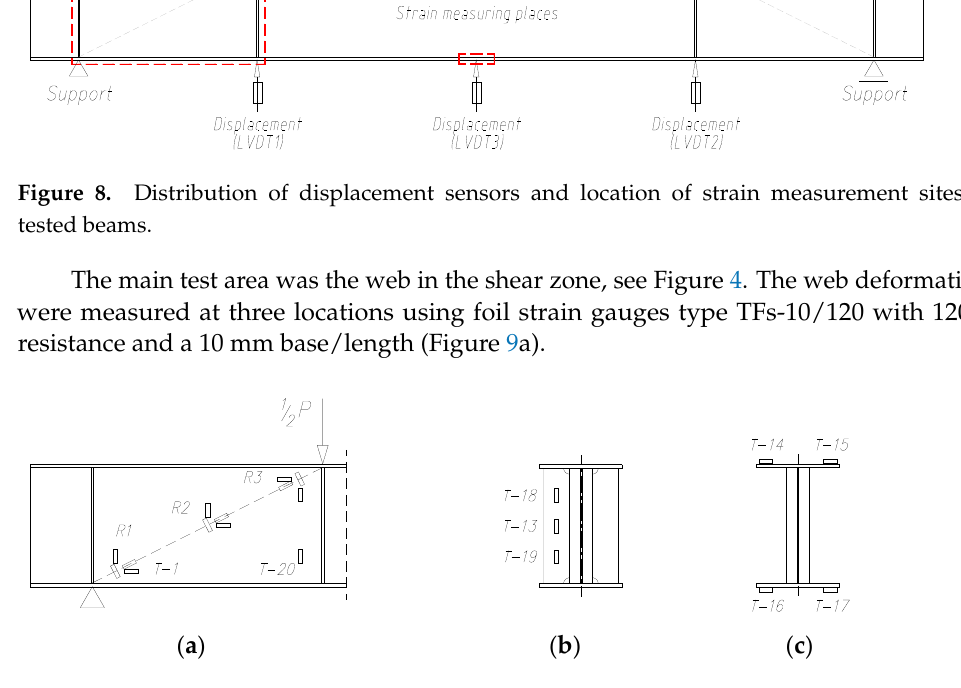
Figure 9. Distribution of strain gauges: ( a ) on the web along the “force–support” line, ( b ) on the vertical rib under the force and ( c ) on the flanges in the middle of the beam span.